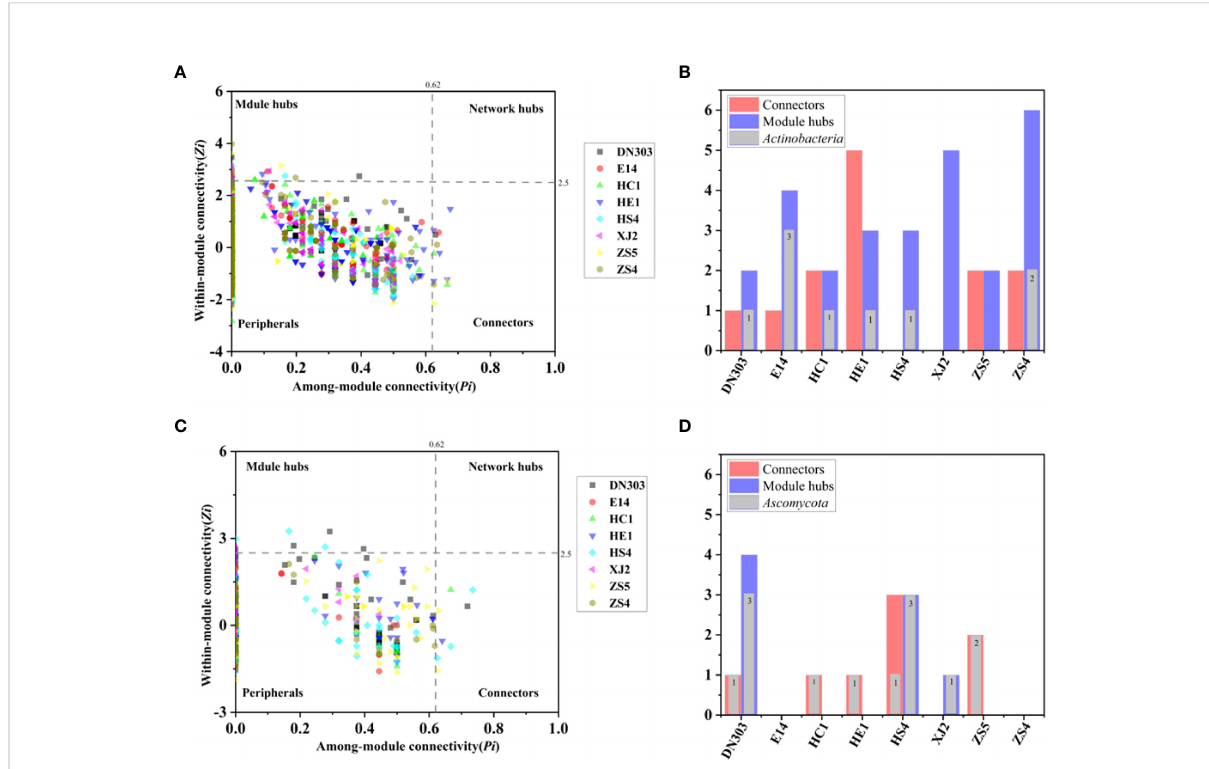
FIGURE 2 Zi-Pi plot and core node distribution of each cultivar. (A, B) Zi-Pi plot of bacterial community. (C, D) Zi-Pi plot offungal community. The digits presented in panels (B, D) represent the number of Actinobacteria and Ascomycota in the core node. All images were generated by Origin 2021